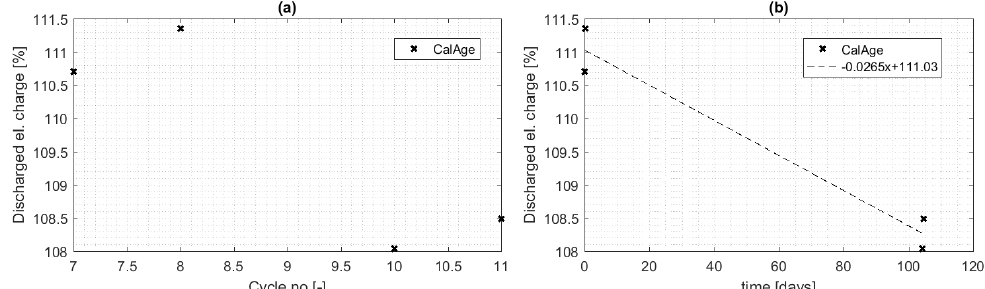
Figure 12. Capacity measured for CalAge cell for capacity test cycles depending on ( a ) cycle number and ( b ) depending on time. Duration between the cycles 8 and 10 was 104.42